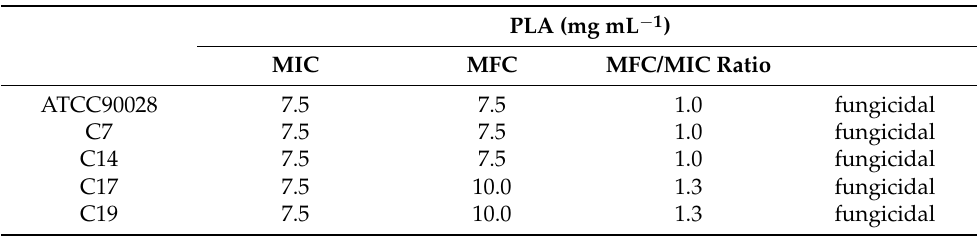
Table 4. Antifungal activity of PLA against Candida albicans isolated from vaginal secretion sam- ples, expressed as minimal inhibitory concentration (MIC; mg mL − 1 ) and minimum fungicidal concentration (MFC).